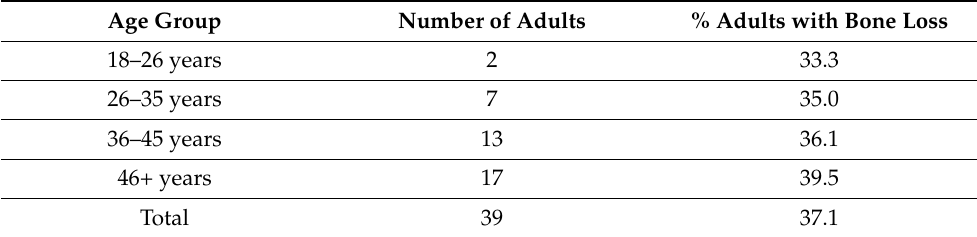
Table 5. Horizontal bone loss by age